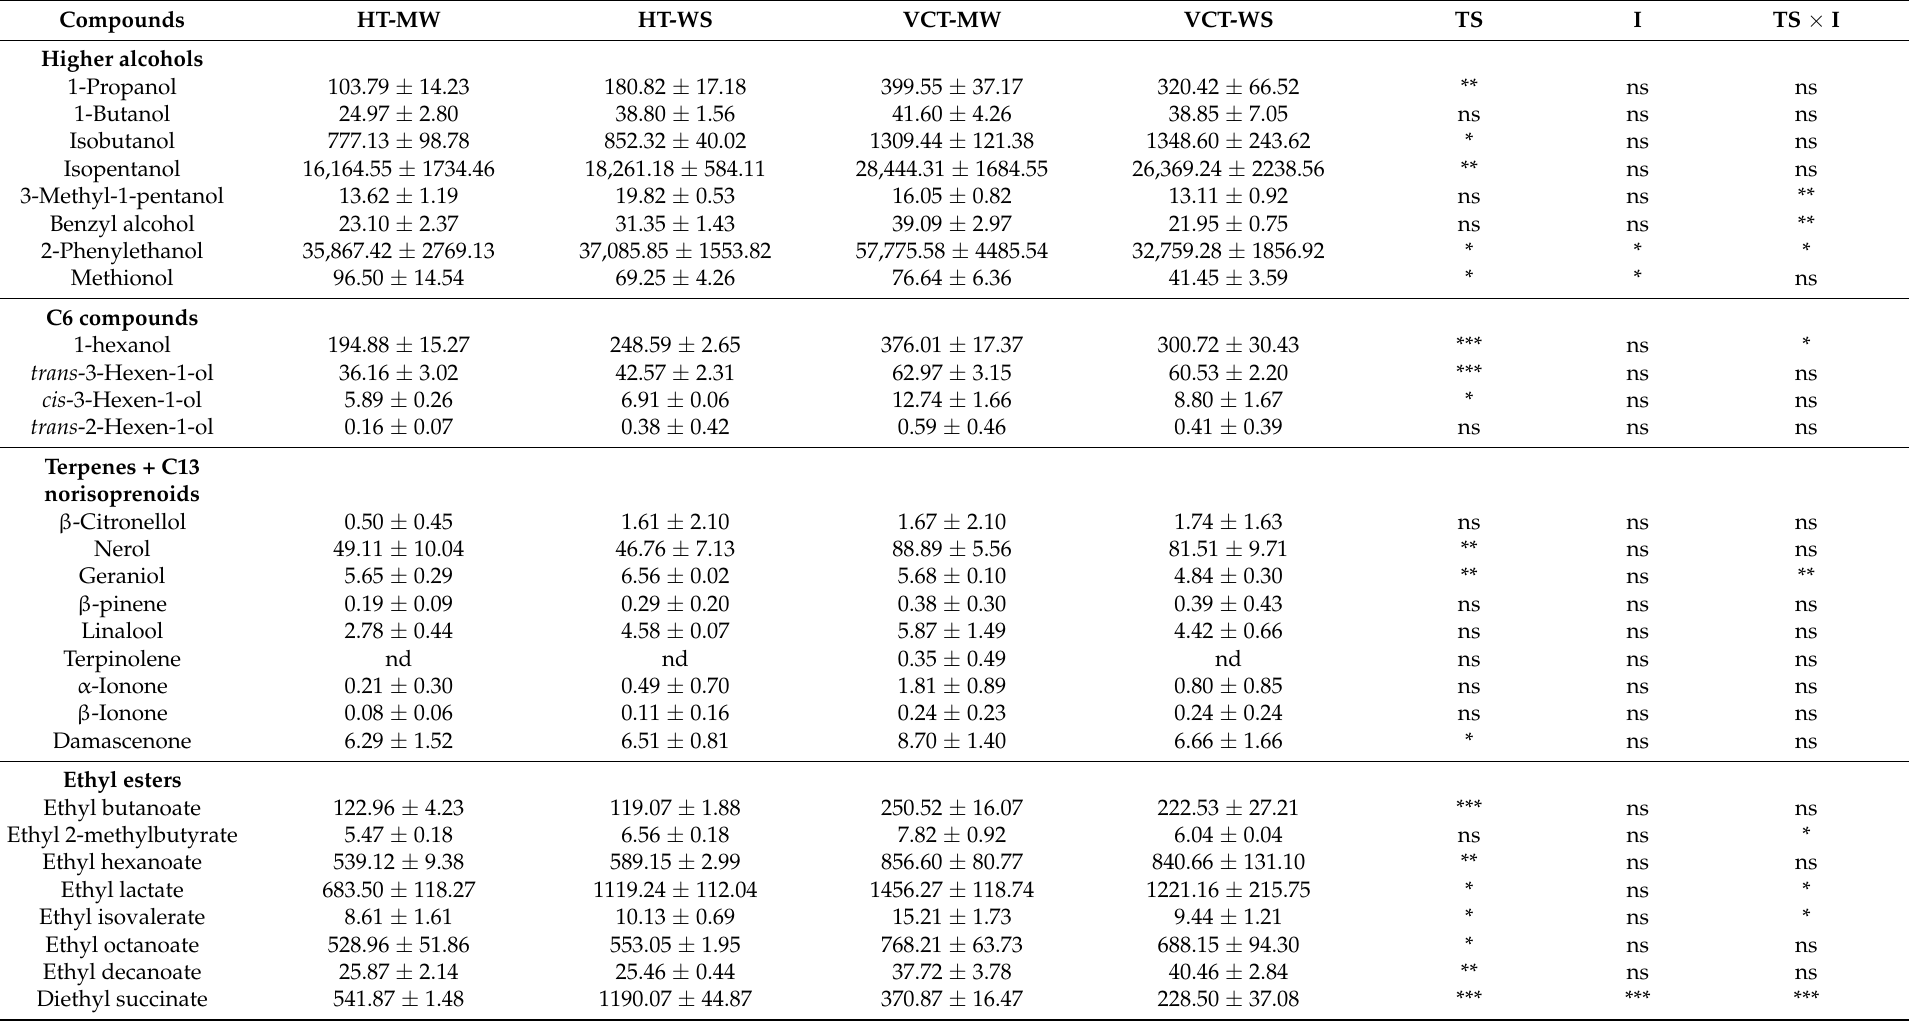
Table 6. Concentration ( µ g L − 1 ) of volatile compounds of Maturana Blanca wines obtained by the different